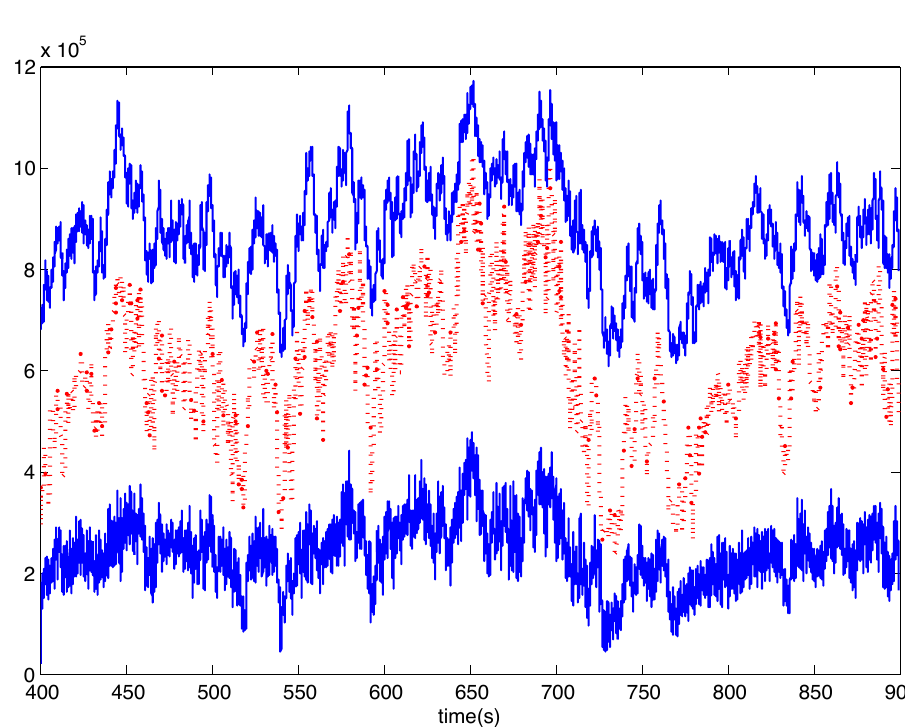
r : τ r dotted line, τ r